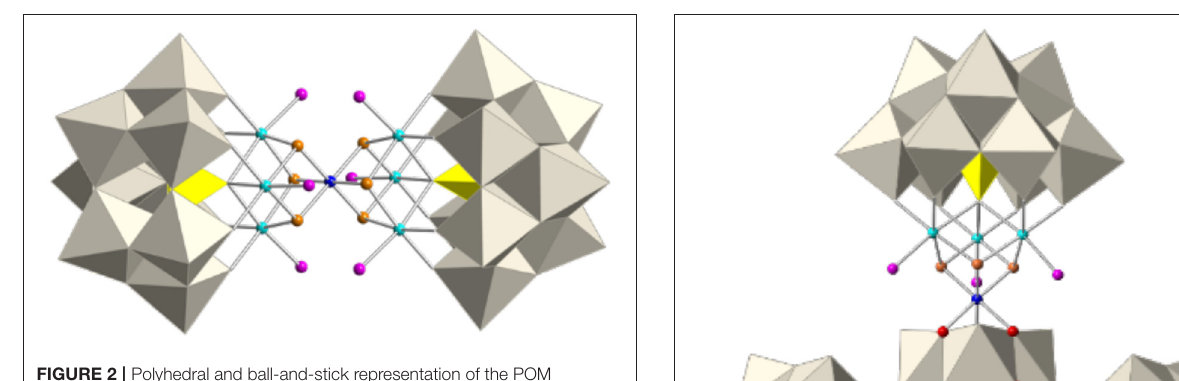
external Co 2 + disordered in two close positions (see Figure S12). BVS calculations confirm that the apical cobalt